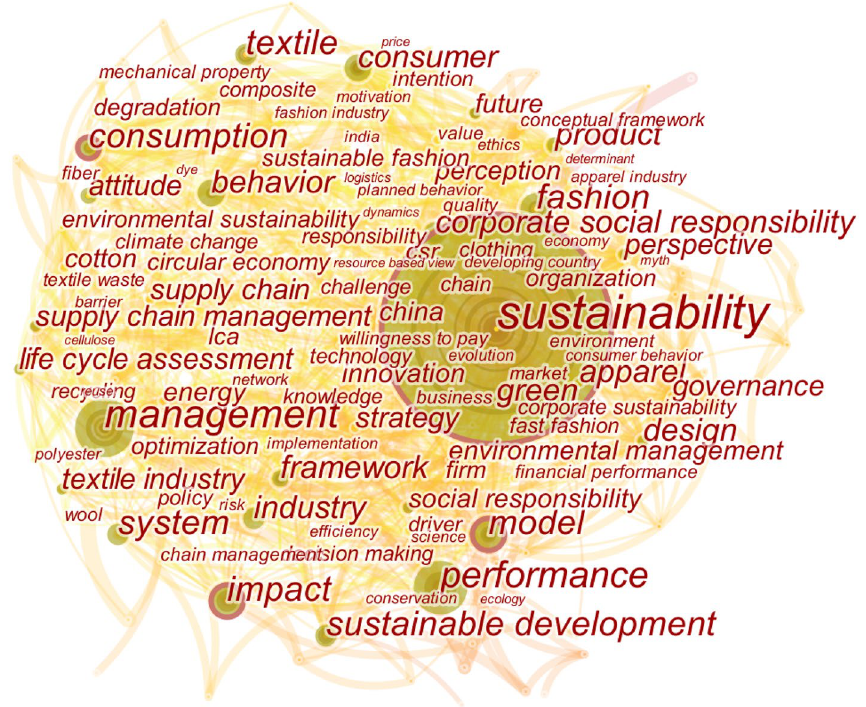
Fig. 1 Keyword co-occurrence network for the sustainable development of the textile and apparel industry